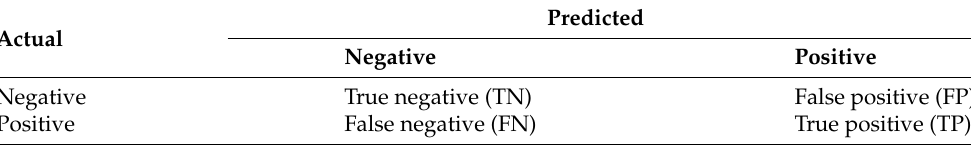
Table 4. Confusion matrix